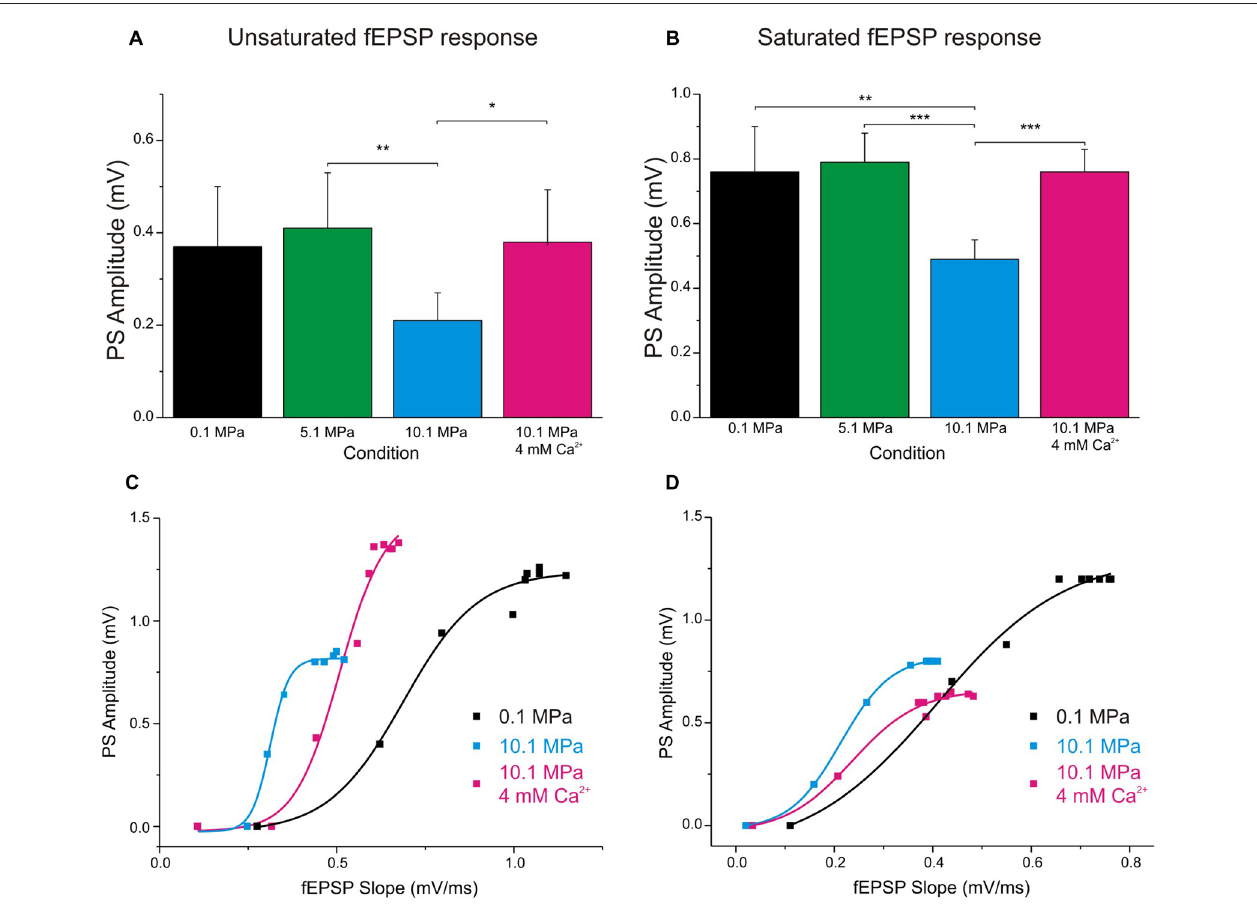
FIGURE 4 | Raising [Ca 2 + ] o enhances single fEPSP inputs and reduces DG’s excitability at 10.1 MPa. Top panels: column bars depict the effect of high pressure and increasing [Ca 2 + ] o (2 to 4 mM) on the amplitude of PSs elicited by a single fEPSP inputs. (A) Effects on the amplitude of PS generated by unsaturated fEPSP inputs ( n = 20 for each condition). Notice the relatively larger variance for the effect of [Ca 2 + ] o . (B) Effects on the amplitude of PS generated by saturated fEPSP inputs ( n = 25 for each condition). Bottom panels: high pressure increases DG’s excitability in response to depressed fEPSPs while high [Ca 2 + ] o enhances single fEPSPs but reduces the DG’s excitability. The consequence of these interactions for GCs’ PS-generation depends on which of these antagonistic factors predominates in the system. High [Ca 2 + ] o often reduces excitability, but its greater strengthening of fEPSP inputs results in increased PS’s amplitude (C) . But